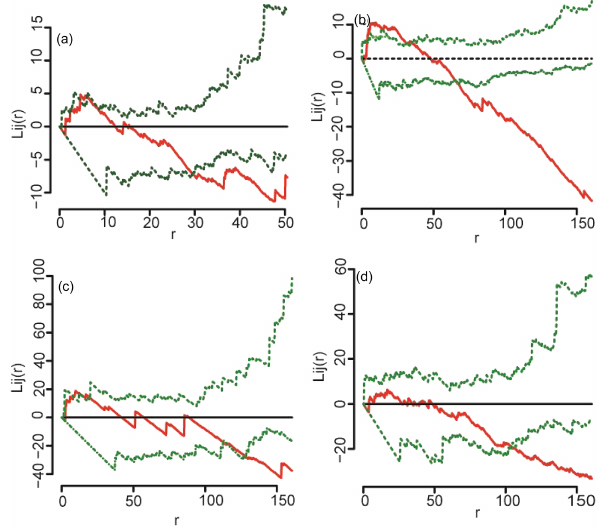
Figure 5. Associations between different classes. Observed patterns (red color, straight line) fallen below and above 95% Monte Carlo intervals (green color, dashed line) stood for the significant dif- ference. The associations between class 1 (10cm ≤ DBH ≤ 15cm) and class 2 (15cm < DBH ≤ 20cm) in the grazed plot was shown in (a) . The associations between class 1 (10cm ≤ DBH ≤ 15cm) and class 2 (15cm < DBH ≤ 20cm) in the fenced plot was shown in (b) . The associations between class 1 (10cm ≤ DBH ≤ 15cm) and class 3 (DBH>20cm) was shown in (c) . And the associations between class 2 (15cm < DBH ≤ 20cm) and class 3 (DBH>20cm) was shown in (d)